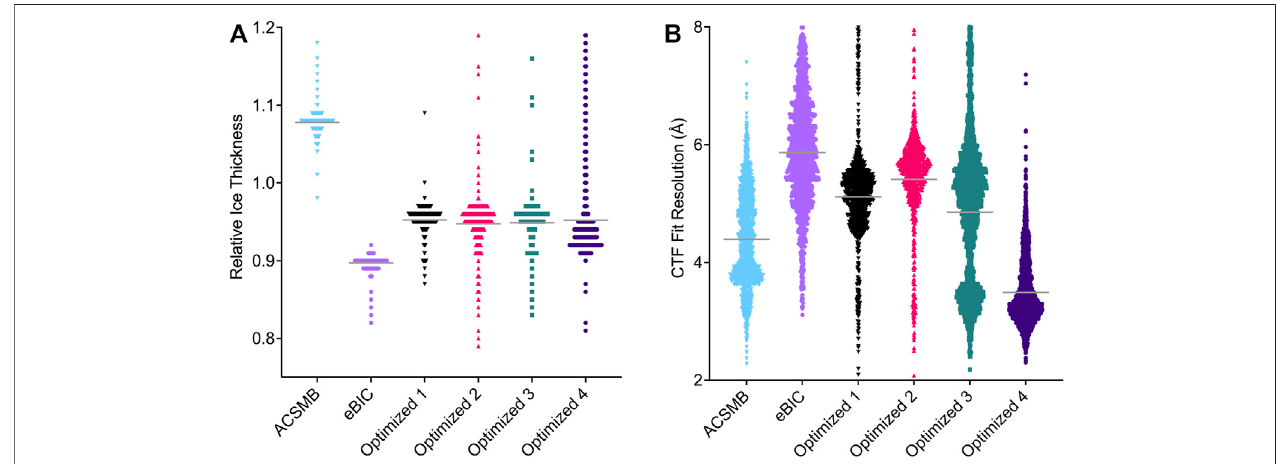
FIGURE4| Comparison ofCTFparametersestimated foreach Cryo-EM dataset. Eachpoint represents anindividualimage andthewidth ofpointsisproportional tothenumberofimagesestimatedatthatvalue. (A) Estimatedrelativeicethicknessforeachimage.Solidgrayhorizontallinesrepresentthemeanvalue(ACSMB=1.10, eBIC=0.90,optimizeddataset1=0.95,2=0.97,3=0.97,4=0.96).Imageswithanestimatedvalueabove1.2wereexcluded. (B) EstimatedCTF fi tresolutionforeach image. Solid gray horizontal lines represent the mean value (ACSMB = 4.39 Å, eBIC = 5.86 Å, optimized dataset 1 = 5.11 Å, 2 = 5.41 Å, 3 = 4.85 Å, 4 = 3.49 Å). Images with an estimated value above 8 Å were